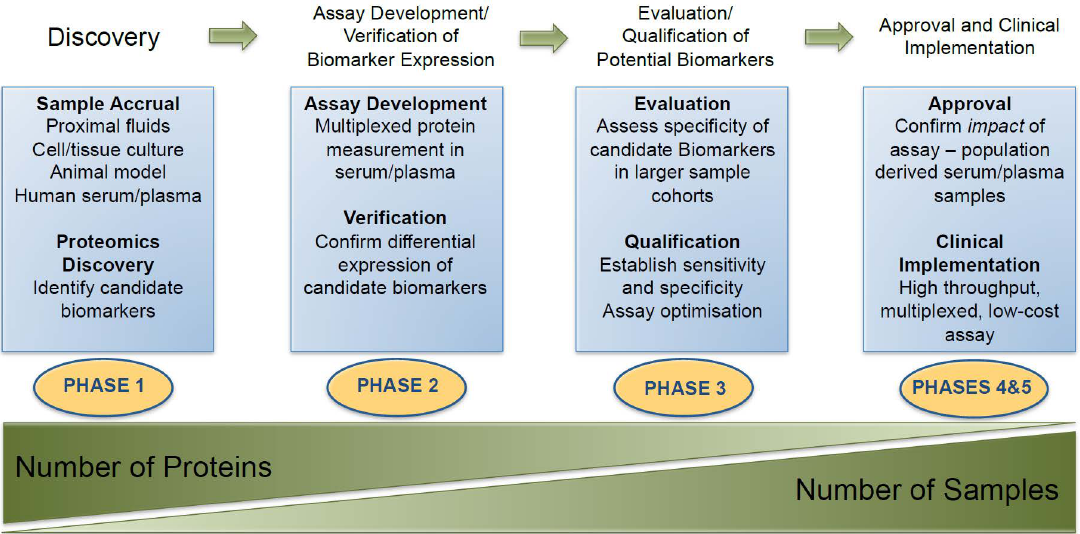
Figure 5. Discovery and Clinical Implementation of Protein Biomarkers: outline of the process involved in bringing candidate protein biomarkers through from the discovery phase, evaluation and ultimately to adoption as a clinical assay for subsequent validation (Figure adapted from Rifai et al., 2006 [116].